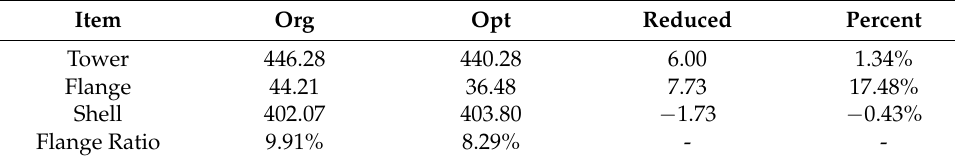
Table 2. Optimization weight results summary of 3 MW tower [ton].